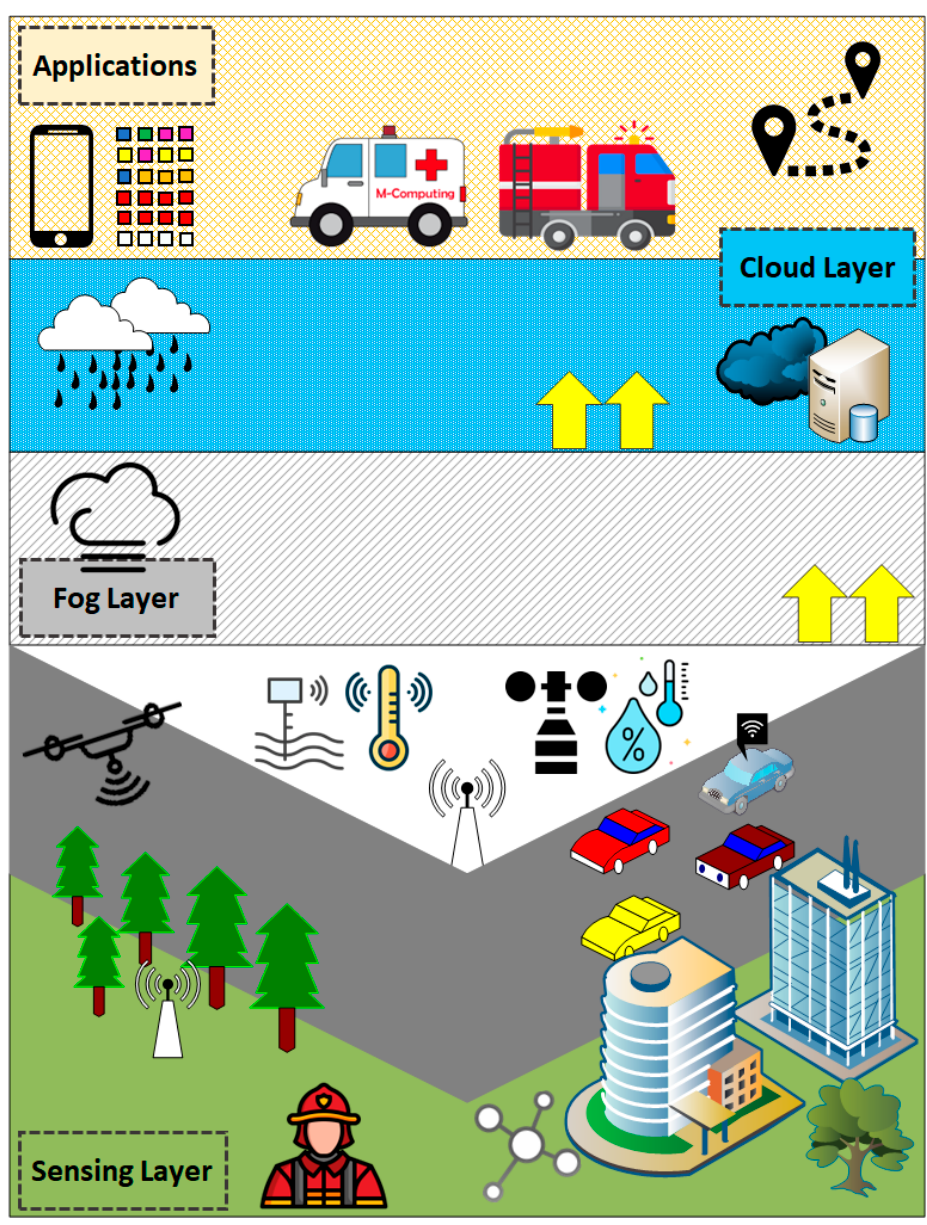
Figure 2. Proposed framework—general view.